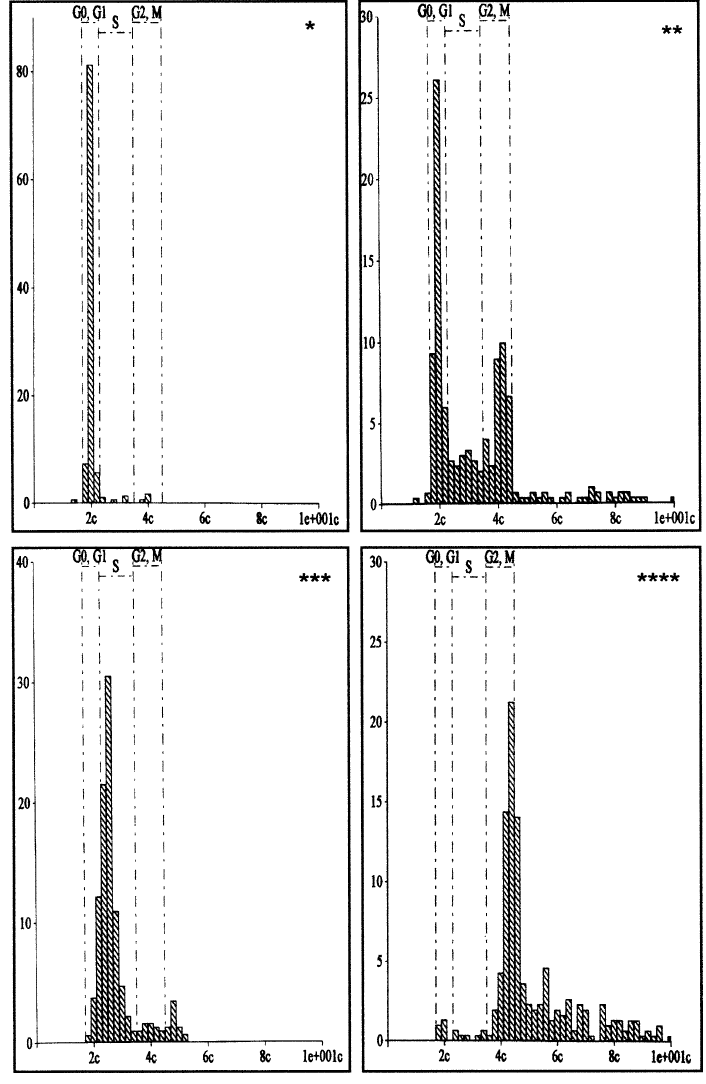
Fig. 2. Histograms illustrating intratumoral DNA-ploidy different results: ∗ a diploid case, ∗∗ an aneuploid hyperdiploid case, ∗∗∗ an aneuploid triploid case and ****an aneuploid tetraploid